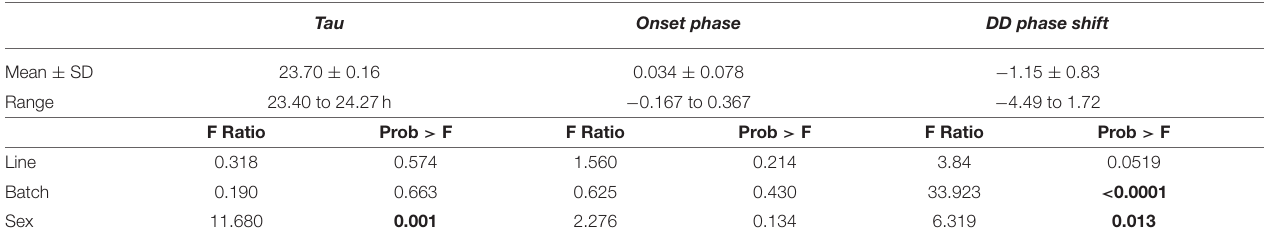
TABLE 1 | Effects of line, batch, and sex on three different measured circadian